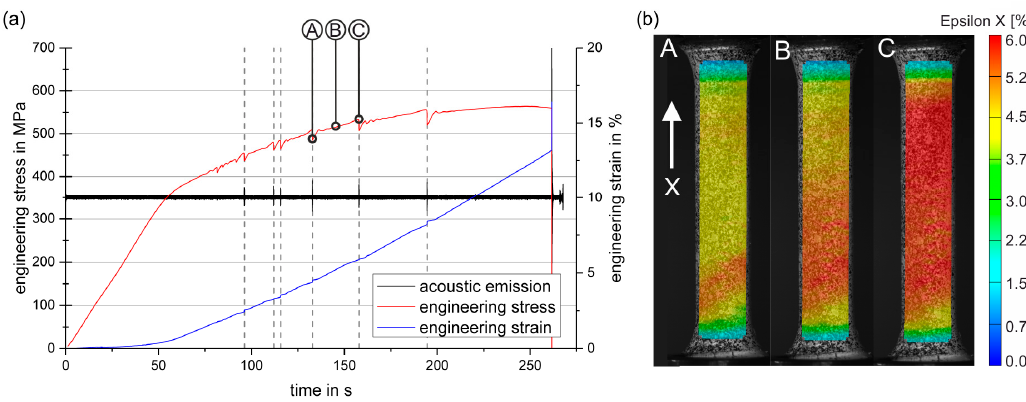
Figure 8. ( a ) Engineering stress, engineering strain and acoustic emission signal (the signal simply represents the integral acoustic intensity) as a function of testing time during uniaxial tensile testing of the particle reinforced material (W-condition) at RT. The stress signal (red) shows distinct stress- drops accompanied by strain discontinuities (blue curve) and a perceptible acoustic emission (black curve). ( b ) Strain fields measured by DIC (uniaxial tensile strain maps) at different stages of the evolution of a single PLC band (type A): Nucleation (A) and propagation (B to C) of a single deformation band.